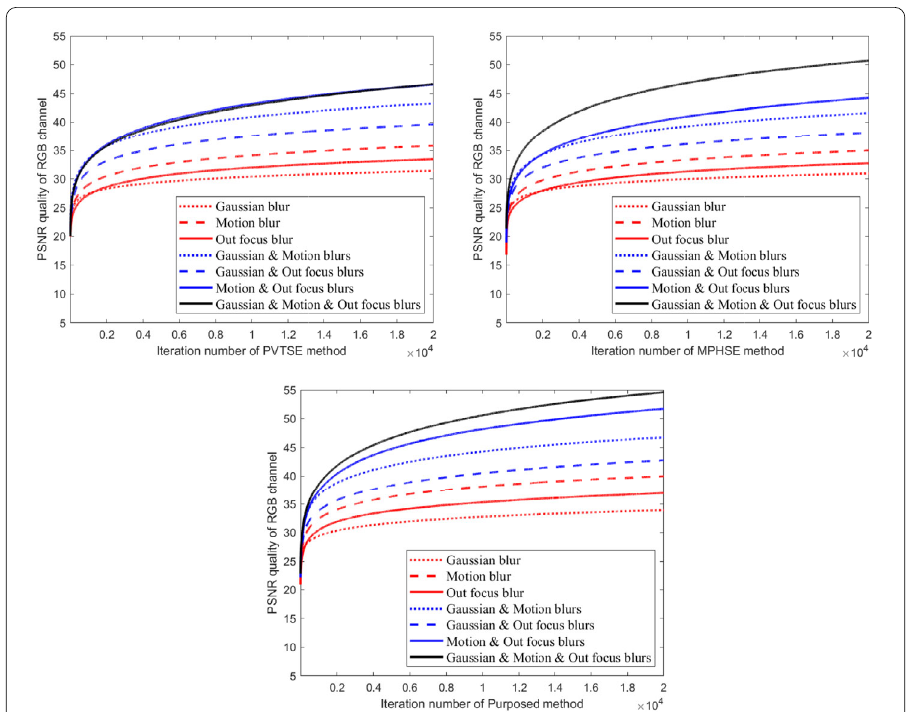
Figure 6 PSNR quality plots of PVTSE, MHPSE, and the proposed algorithms in all cases of RGB images